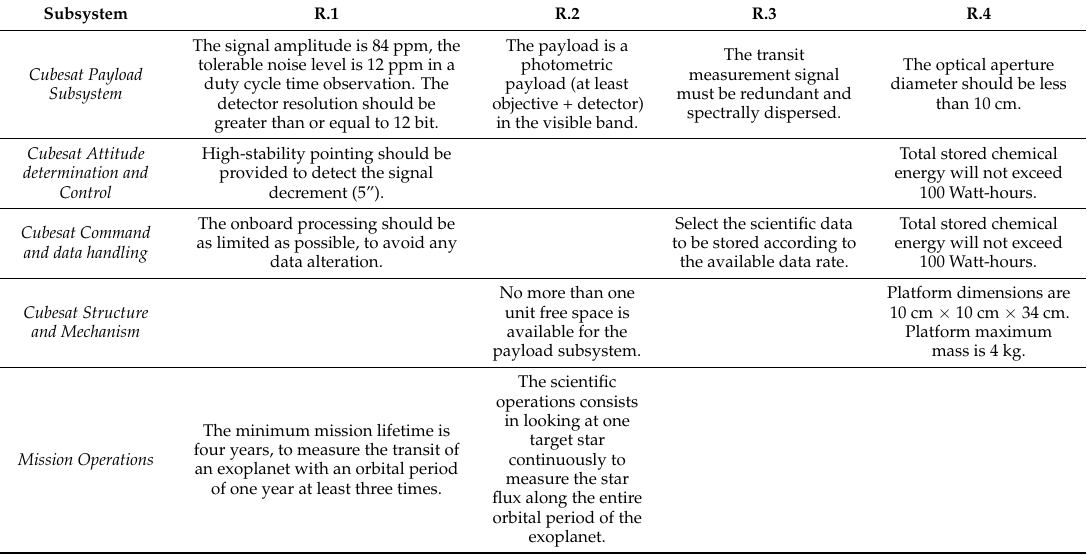
Table 1. Matrix of subsystem requirements.